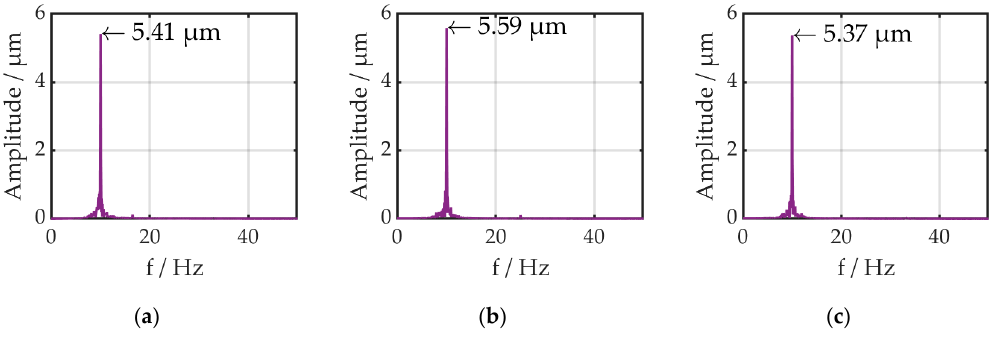
Figure 9. Amplitude with increasing rotation speeds: ( a ) 1000 rpm, ( b ) 1500 rpm, ( c ) 2000 rpm. The amplitude varied from 5.41 µm up to 5.59 µm to 5.37 µm. The deviation is 8% and so the influence of the rotation speed is minimal.